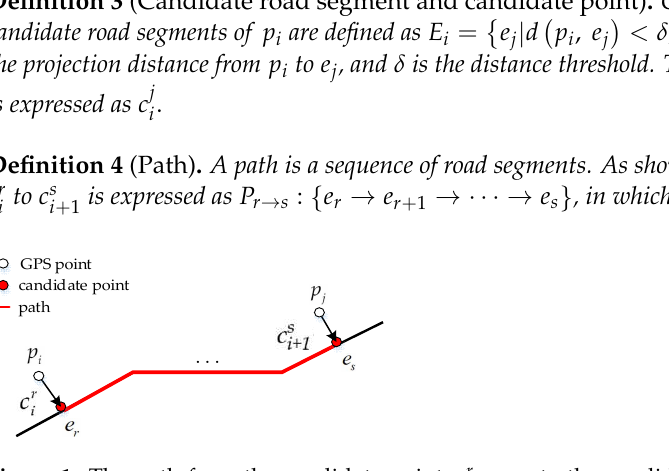
, and c js is the projection point of p is the projection point of p i + 1 i j